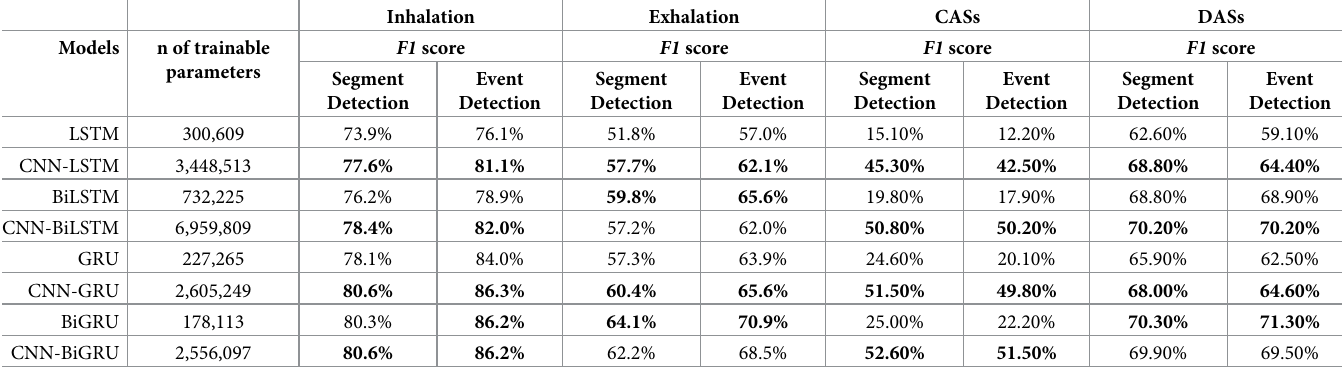
Table 6. Comparison of F1 scores between models without and with a